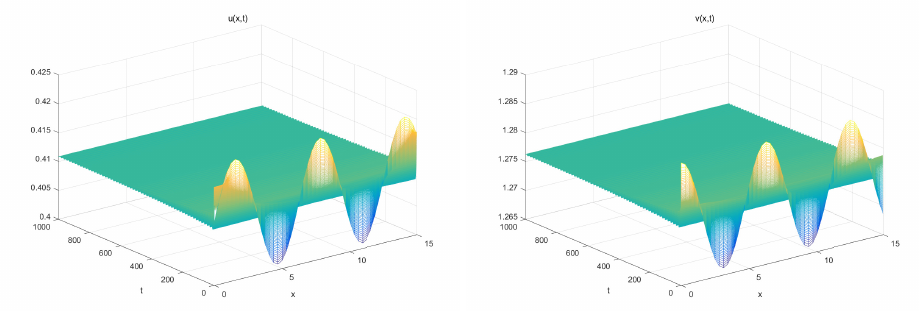
Figure 3. The numerical simulations of system (3) with τ = 1 and other parameters is given by (52). Left : component u . Right : component v .